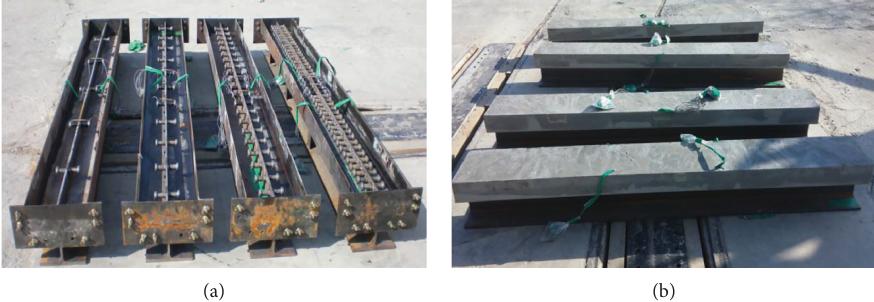
Figure 3: Fabrication of the composite beam with inverted-Tsteel girder. (a) Inverted-Tsteel girder with steel form: stud spacing of 400, 200, 100, and 50mm from left to right. (b) Completed composite beams: stud spacing of 400, 200, 100, and 50 mm from top to